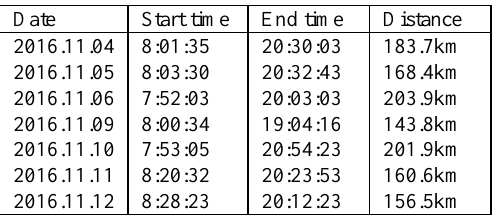
Table 1. Trajectory basic information